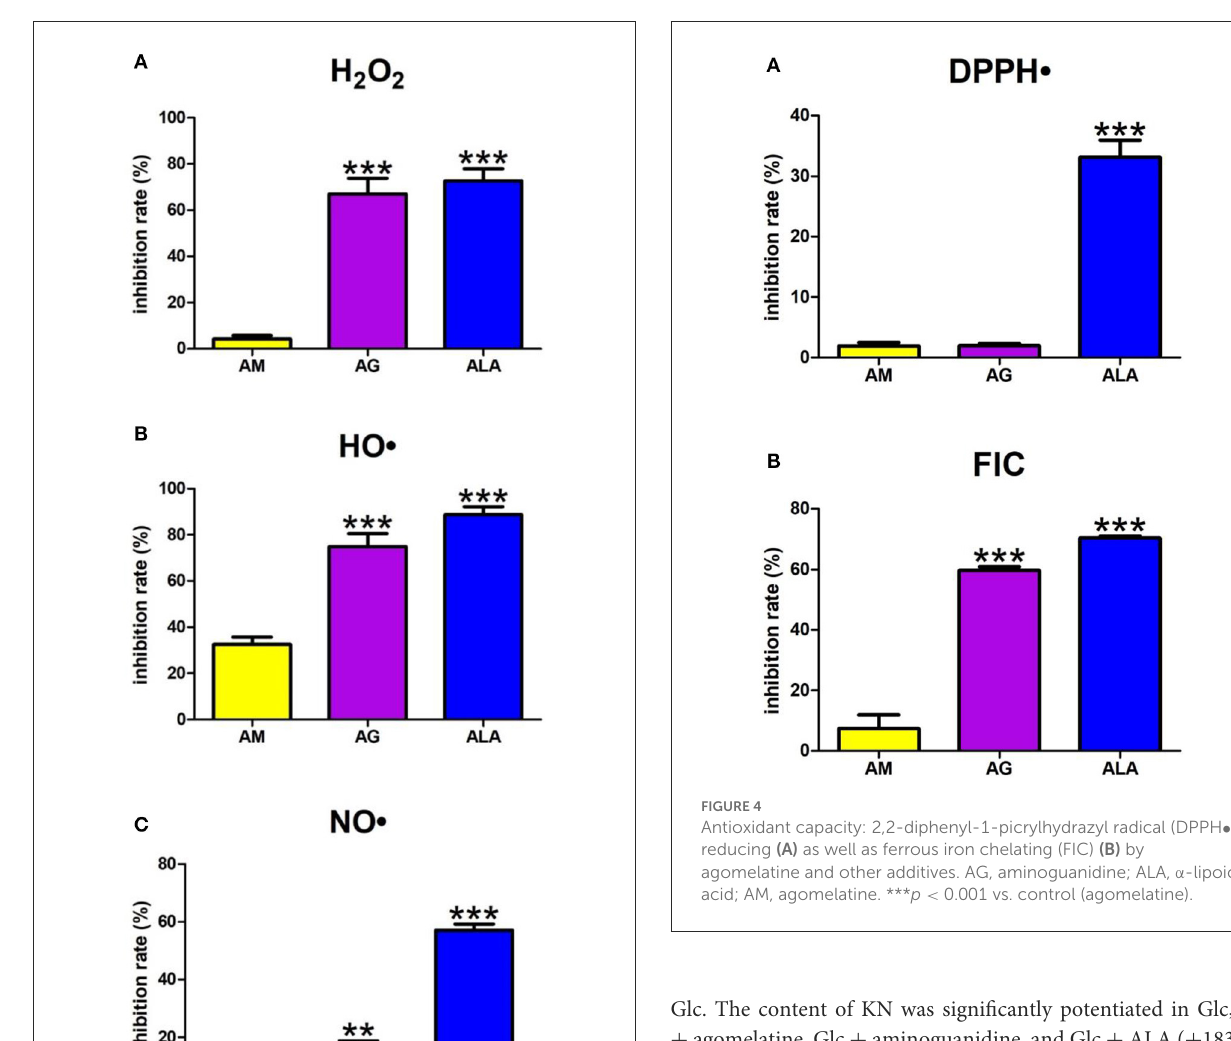
and ALA ( + 708%, p < 0.0001 and + 853%, p < 0.0001, respectively) (Figure 4B).